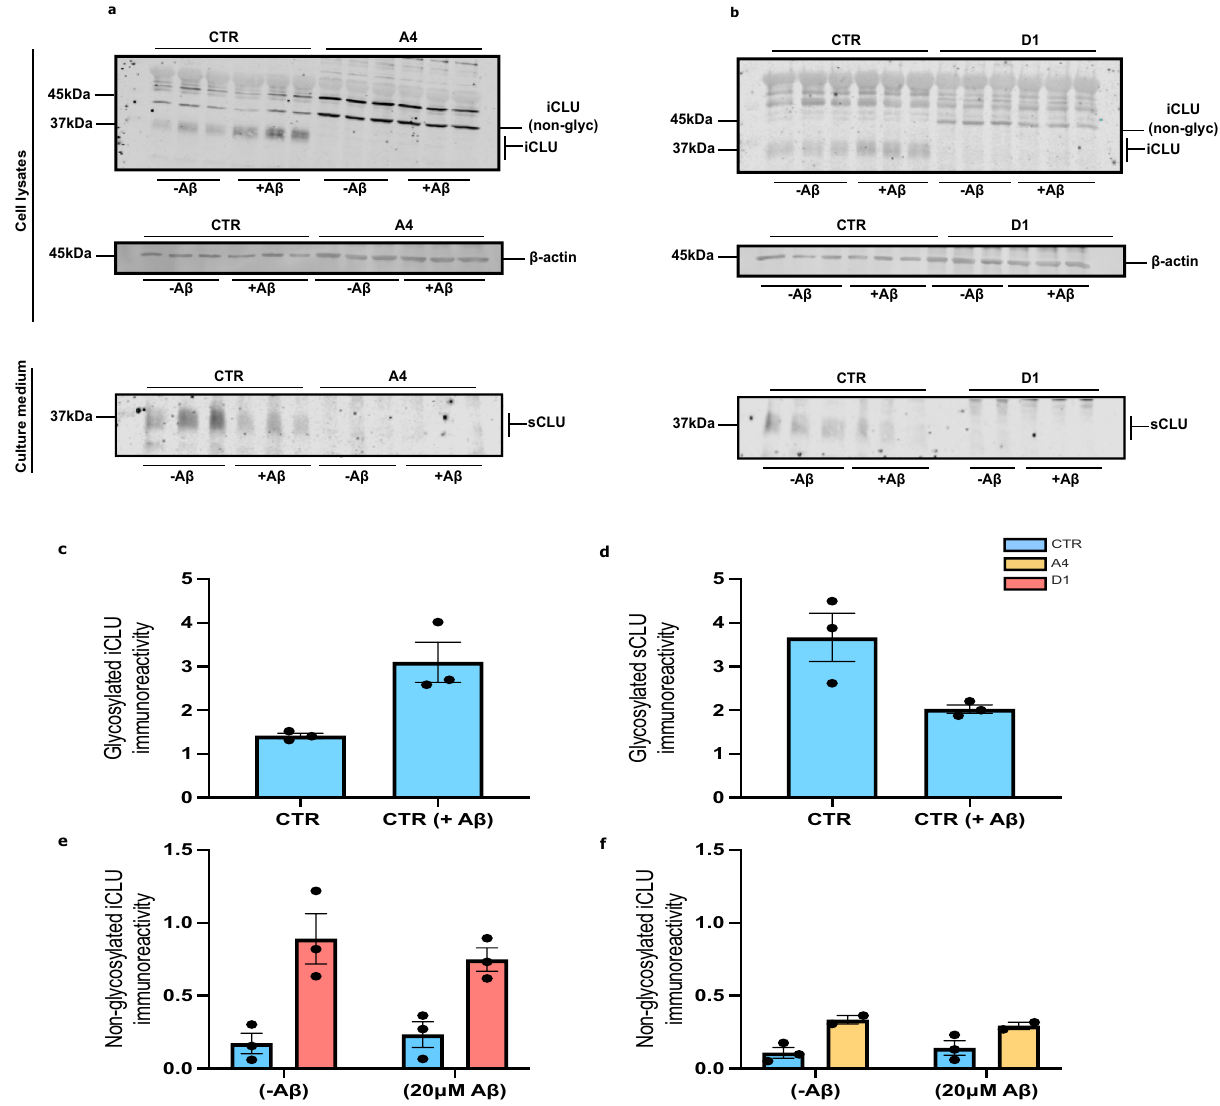
Figure 1. Aβ 25–35 treatment alters trafficking of glycosylated CLU in human neurons. CTR and exon 2 −/− neurons (A4 and D1) were treated for 24 h with 20 μM Aβ 25–35 . Concentrated media and total cell lysate samples were collected, ran on a western blot and immunostained for CLU. ( a ) Western blot analysis of clusterin expression in cell lysate and culture media of untreated and Aβ 25–35 treated CTR and A4 neurons ( b ) and untreated and Aβ 25–35 treated CTR and D1 neurons. In both ( a ) and ( b ) β-actin were used as a loading control for protein loading of cell lysate samples. The absence of β-actin expression was confirmed in all culture media samples. ( c , d ) CLU immunoreactivity in cell lysates was normalised to β-actin immunoreactivity for each sample individually. This was then normalised to the immunoreactivity of the untreated CTR samples. ( c ) Intracellular, glycosylated CLU immunoreactivity was significantly increased (p = 0.0221*) while ( d ) secreted, glycosylated CLU was significantly decreased in CTR neurons (p = 0.0432*) following treatment with Aβ 25–35 . Exon 2 −/− neurons were demonstrated to not express glycosylated CLU proteins, either intracellularly or secreted into the media. ( e , f ) Loss of CLU exon 2 increased immunoreactivity of non-glycosylated CLU proteins in exon 2 −/− neurons at basal conditions (A4: p = 0.0077** and D1: p = 0.0348*) but Aβ 25–35 did not alter the immunoreactivity of non-glycosylated, intracellular CLU species in either CTR or exon 2 −/− neurons (CTR: p = 0.09785 and A4: p = 0.7991, CTR: 0.9255 and D1: p = 0.9154). Immunoreactivity is reported as mean ± standard error of the mean (SEM). Mean values were calculated from neuronal samples collected from three independent differentiations of neurons, of which each contained triplicate samples (n = 3). Two-Way ANOVAs were performed for all comparisons (*p < 0.05, **p < 0.01, ***p < 0.001 and ****p < 0.0001). Western blot images used in this figure have been cropped for clarity, all original blots are presented in Supplementary Fig.